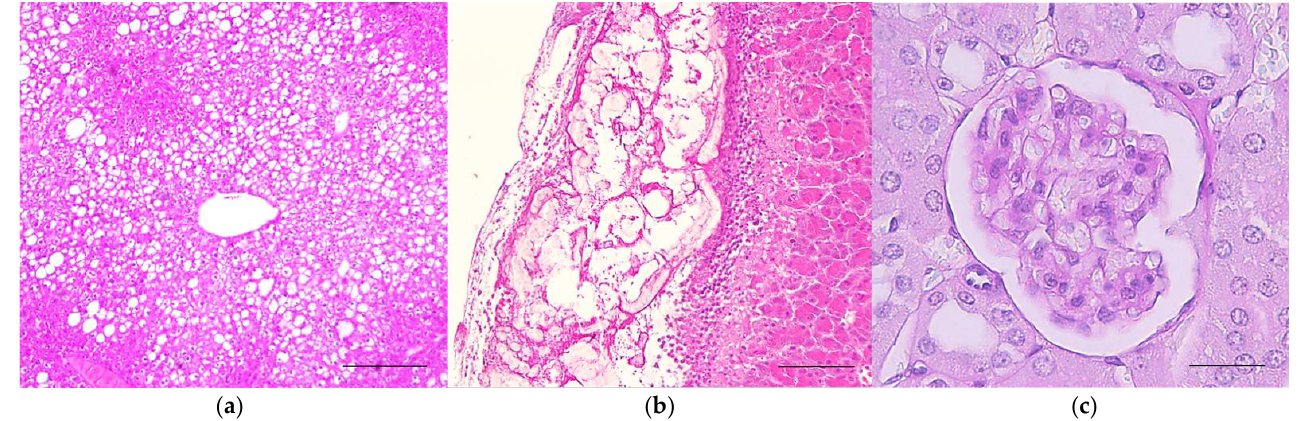
Figure 4. Histopathological analysis in tissues. ( a ) Liver section revealing more pronounced hepatocyte vacuolation in the centrilobular region from a mouse treated with 40.2 mg/kg AoBTHP (40× magnification, hematoxylin, and eosin staining). ( b ) Pancreas section showing foci of necrotic adipocytes, with discrete inflammatory infiltration contiguous with areas of neutrophilic cellular infiltration, at the periphery of a pancreatic lobe from a mouse treated with 127.0 mg/kg AoBTHP (100× magnification, hematoxylin and eosin staining). ( c ) Glomerular section with a basement membrane with normal thickness and mesangial cell nuclei in normal number, from a mouse treated with 127.0 mg/kg AoBTHP (400× magnification, periodic acid-Schiff staining). Scale bars: A = 200 µm; B = 100 µm; C = 20 µm.